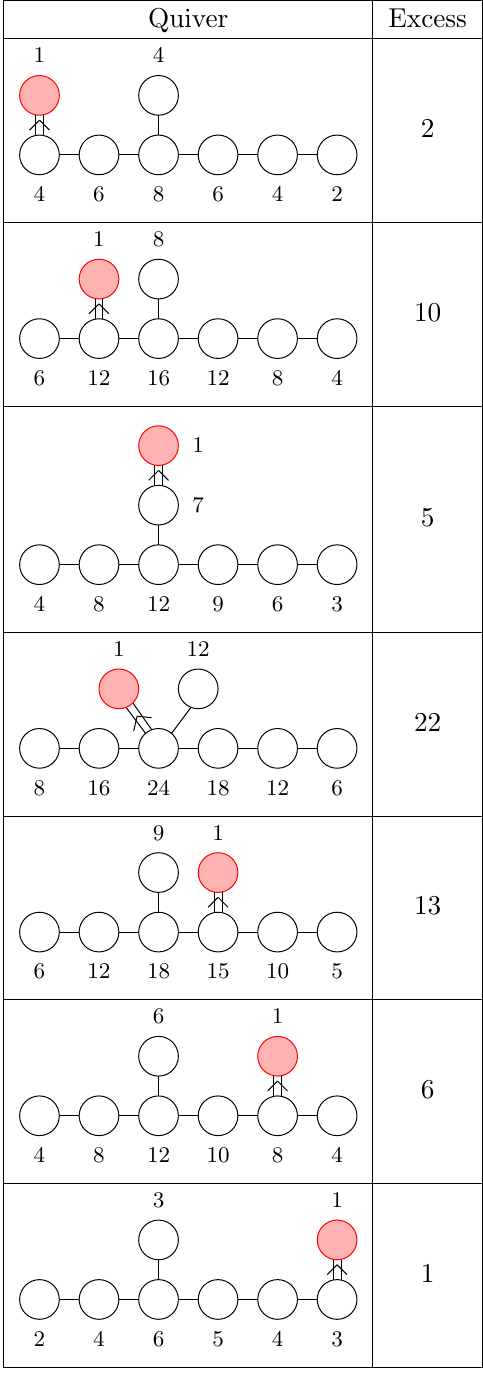
Table 21 . Exotic minimally unbalanced quivers of E 7 -type with inward double laced